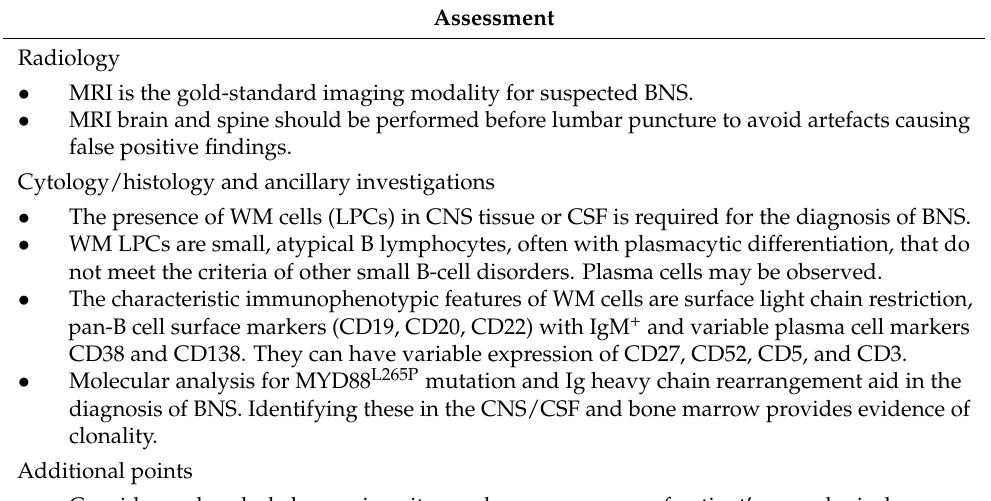
Table 2. Summary of assessment of patients with suspected Bing–Neel